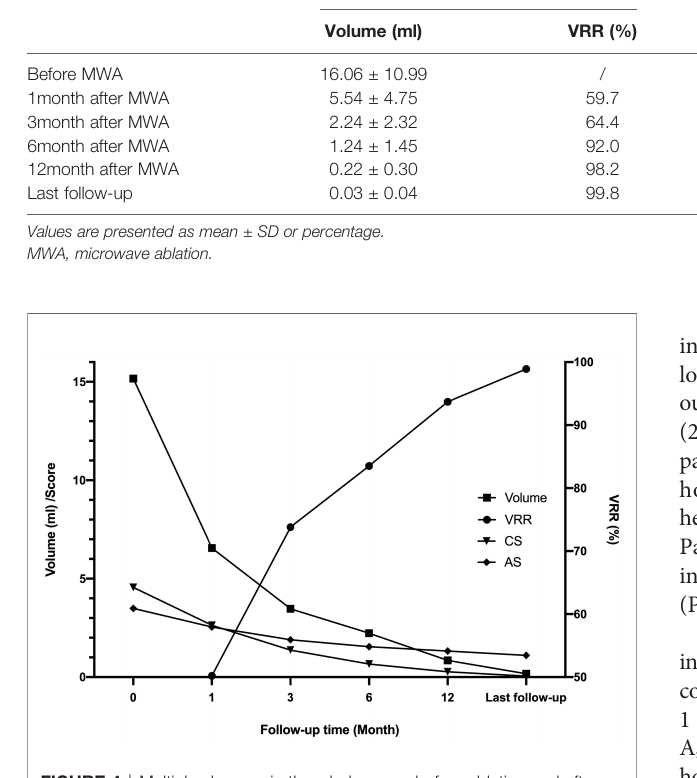
FIGURE 4 | Multiple changes in the whole group before ablation and after follow-up. After MWA, the nodule volume gradually decreased, and the VRR gradually increased. The patient ’ s CS and AS decreased. CS, compressive score; AS, aesthetic score; VRR, volume reduction